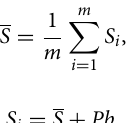
Each shape is represented by a number of points (i.e., vertices) describing the shape surface in 3-dimensional space, and each point is described by three coordinates (x, y, and z). Equation (1) shows a representation, i.e., geometric characteristics, of each shape vector where i = 1…m (m is the number of shapes in the data set) and j = 1…n (n is the number of vertices in each surface mesh). An average TD surface mesh was selected as a reg- istration reference for both cohorts. The surface meshes of both groups were fitted against the reference mesh (non-rigid registration) using radial basis functions 20 . The fitted meshes were aligned (rigid registration) based on their center of mass and principal axis of inertia coordinate system to remove translation and rotation mis- alignment. A dimensionality reduction and eigen-analysis method—principal component analysis (PCA)—was applied to generate a mean shape, refer to (2), and a covariance matrix representing each mesh in the data set. − S , eigenvectors b and corresponding The eigen-analysis of the PCA yielded a combination of a mean shape, eigenvalues P that can approximate each shape in the data set, refer to (3). The generated mean shape was used as a reference in an iterative refitting process of the data set until the fitting accuracy (RMS) was brought down to 0.86 mm and 0.87 mm for CP and TD cohorts respectively 16 .